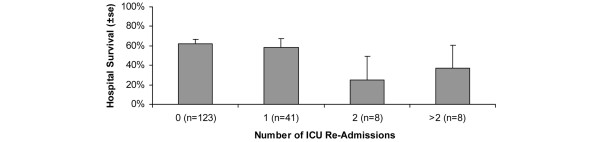
Hospital survival by number of ICU readmissions during the hospital stay. ICU, intensive care unit; se, standard error.